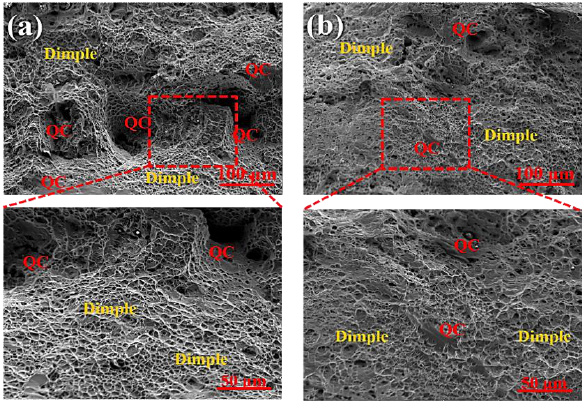
Figure 9. Microstructures near the tensile fracture position tested at 289 K in each weld using: ( a ) STS 308L filler and ( b ) HEA filler.